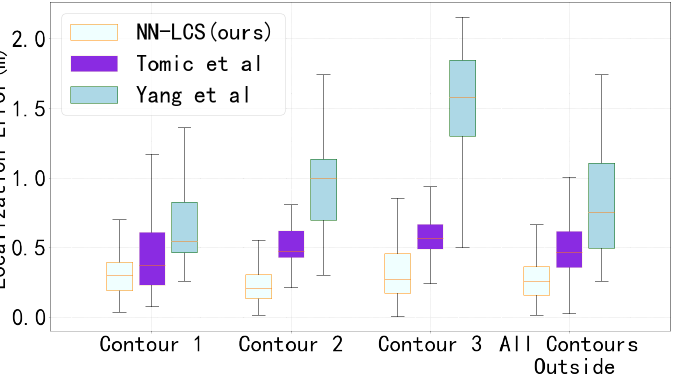
Figure 7. Boxplot of the localization error comparison (m). The test points are contour 1 (1-1,1-2...,1- 12), contour 2 (2-1,2-2...,2-12), and contour 3